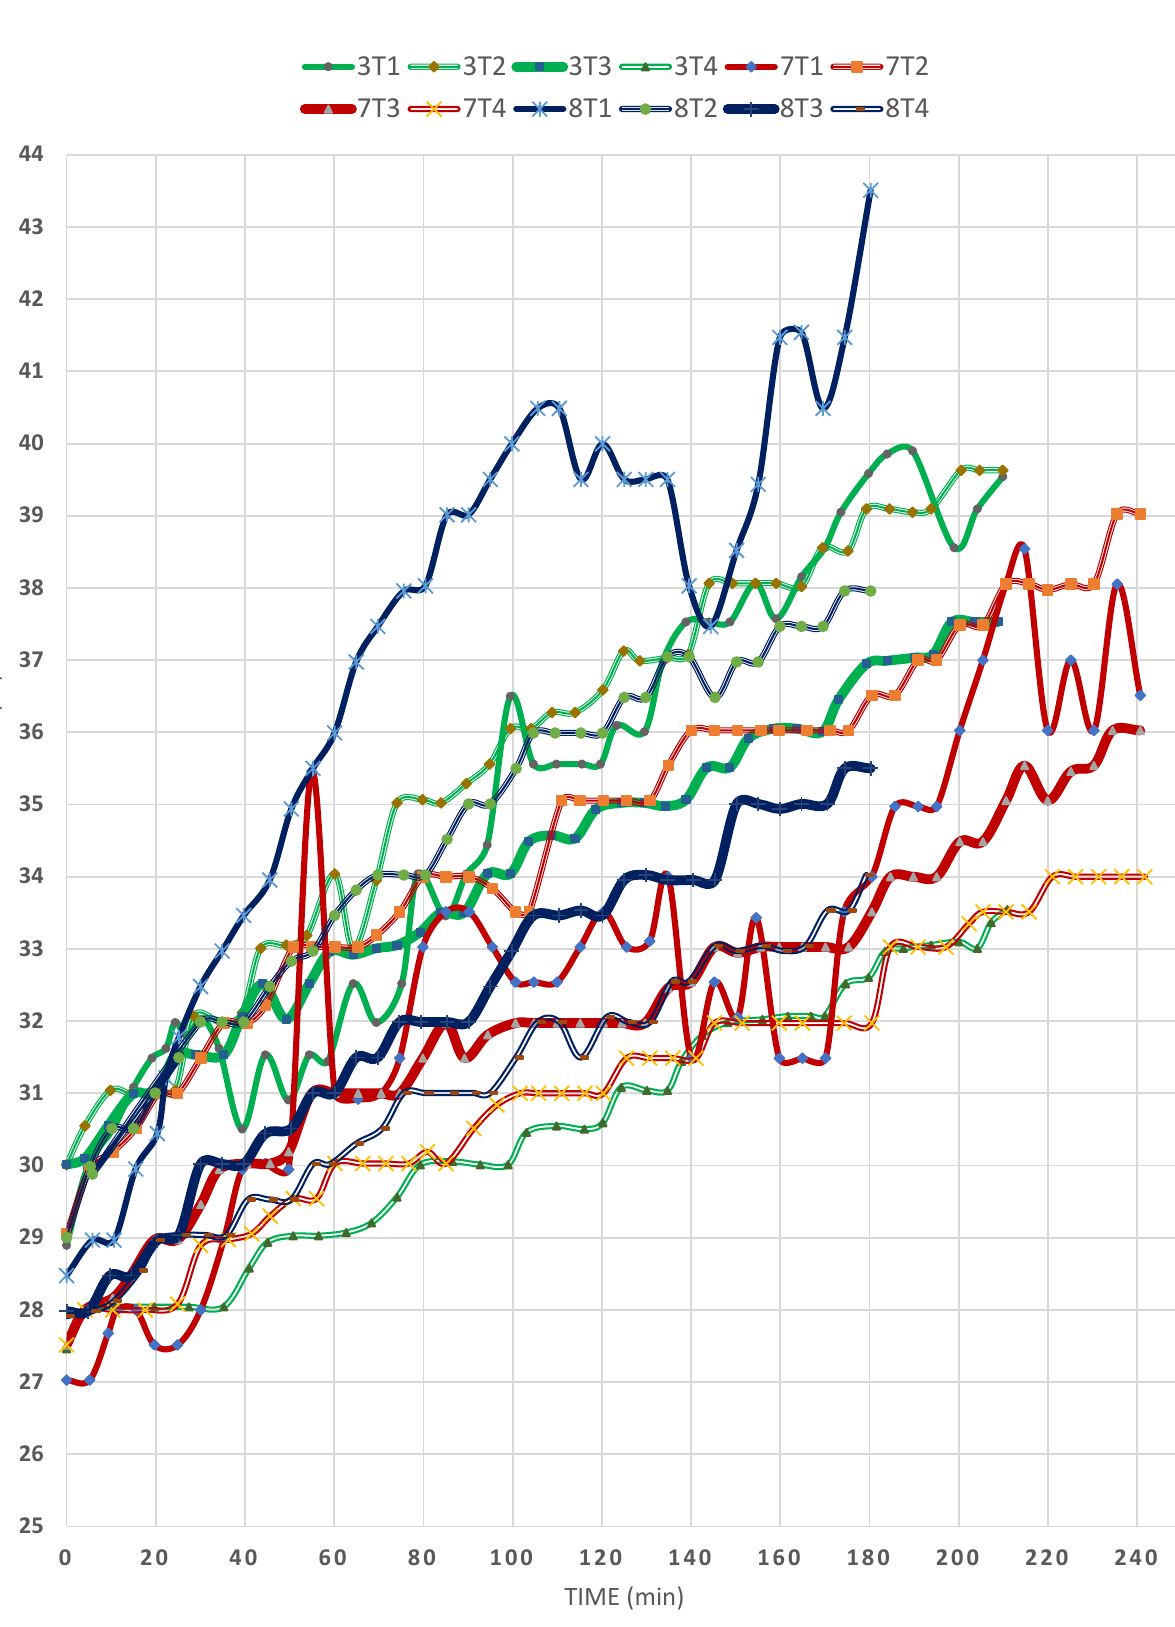
Figure 6. Effect of wind speed on the temperature profiles in the SP (EXPs 3, 7 and 8).